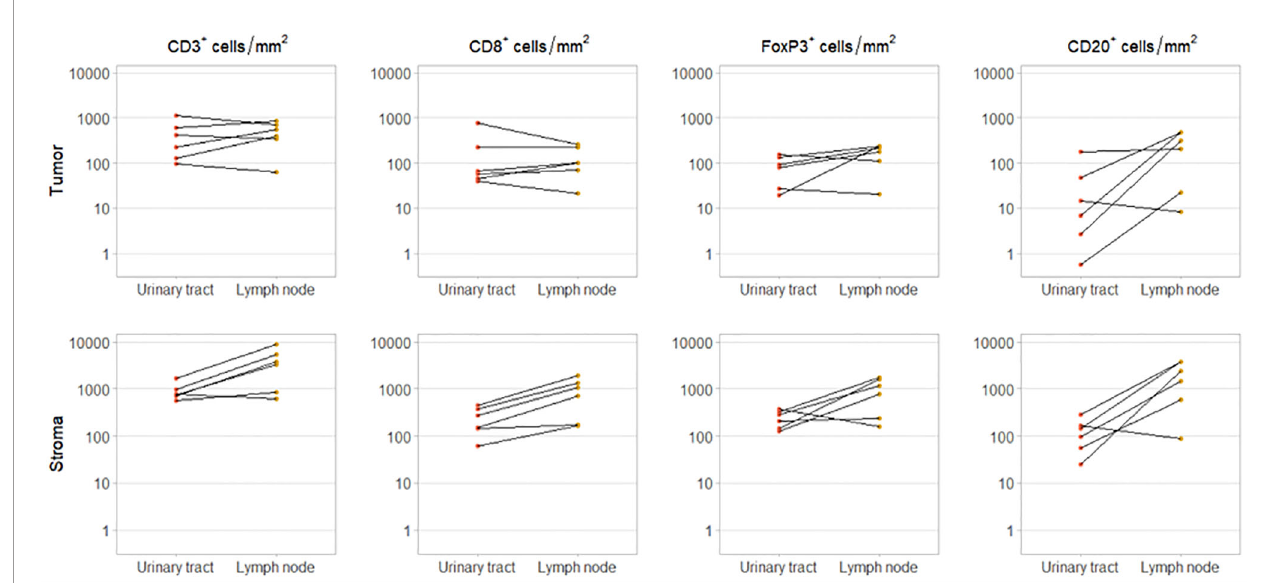
FIGURE 3 | Immune cell in fi ltration in primary tumor and synchronous lymph node metastasis. Intratumoral (upper panel) and stromal (lower panel) CD3 + , CD8 + , FoxP3 + and CD20 + cell densities in paired urinary tract and lymph node samples. These samples were obtained during the same